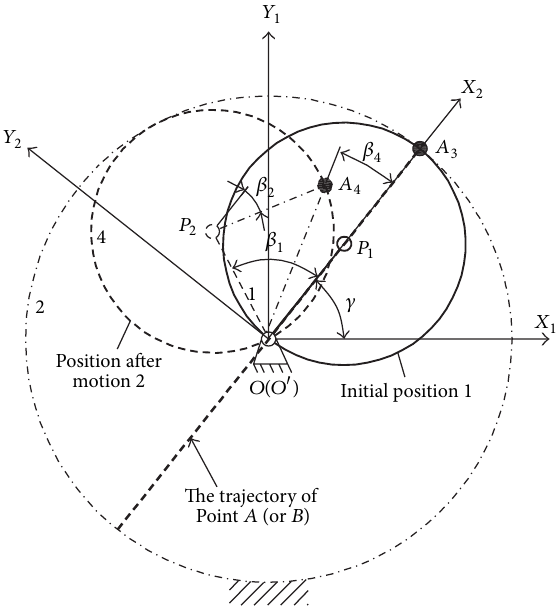
Figure 3: The working mechanism of linear